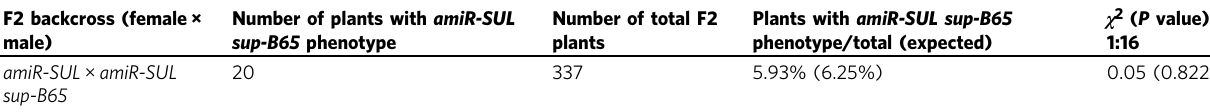
Table 1 Segregation analysis in the F2 population F2 backcross (female × male)